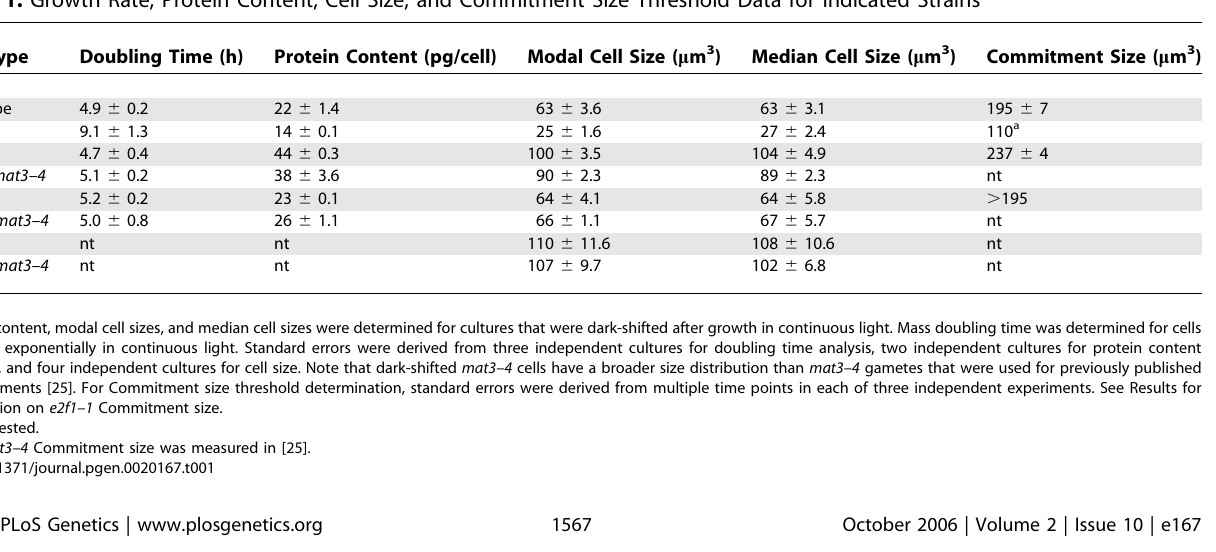
Table 1. Growth Rate, Protein Content, Cell Size, and Commitment Size Threshold Data for Indicated Strains Genotype